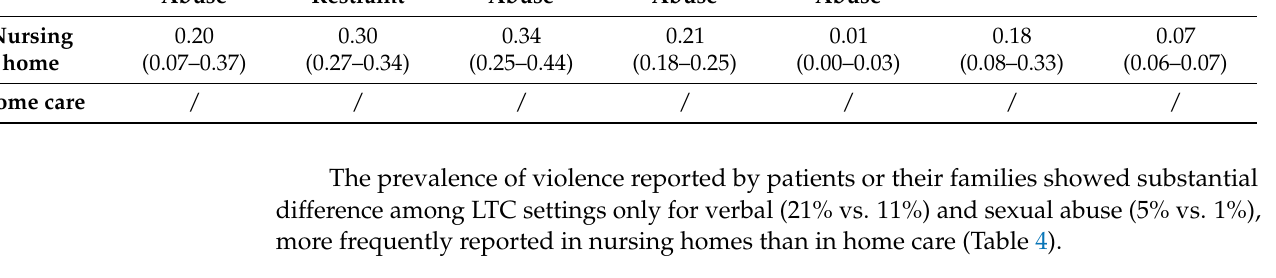
Table 4. Patient or family self-reported violence in different LTC